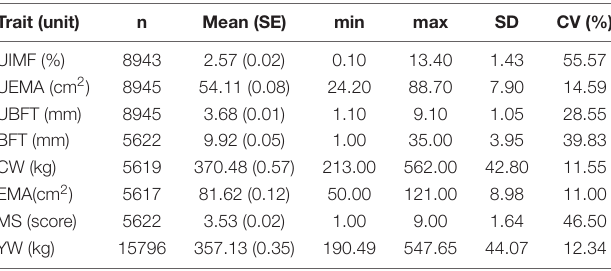
TABLE 1 | Descriptive statistics for the ultrasound at 12 months of age, carcass traits, and yearling weight in Hanwoo cattle. Trait